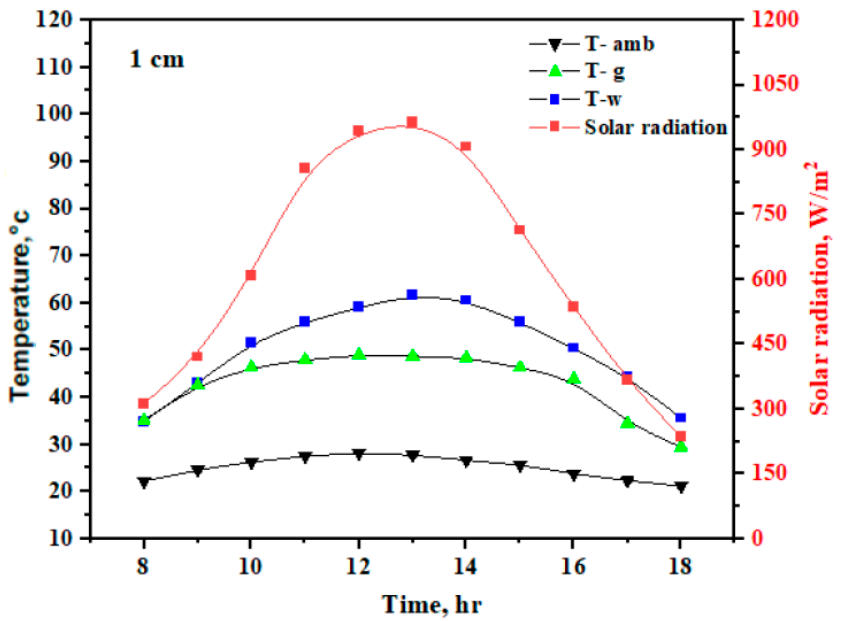
Figure 3. Daily variations of temperature and solar intensity of the still with 1 cm water depth.